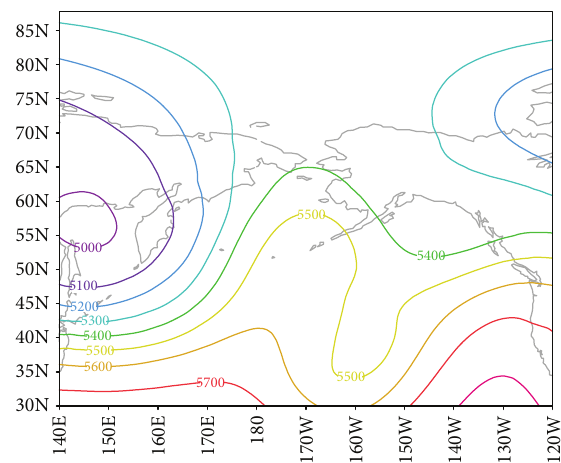
Figure 8: GEFS ensemble mean time-averaged geopotential heights for March 9–14, 2013.